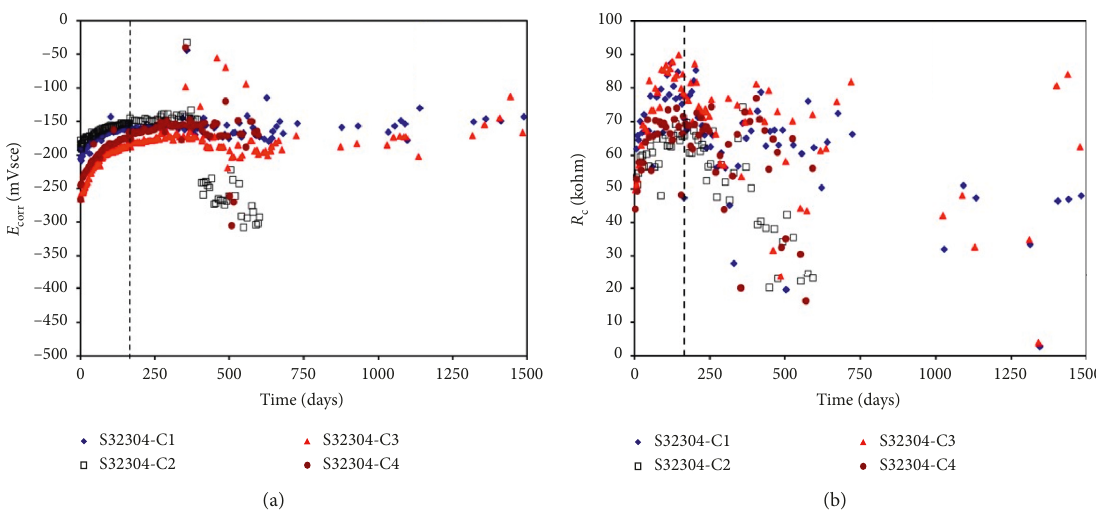
Figure 3: Evolution of potential and linear polarization resistance on mortar specimens S32304-C (w/c � 0.5, wet/dry cycles began on the day indicated by the vertical dash line).